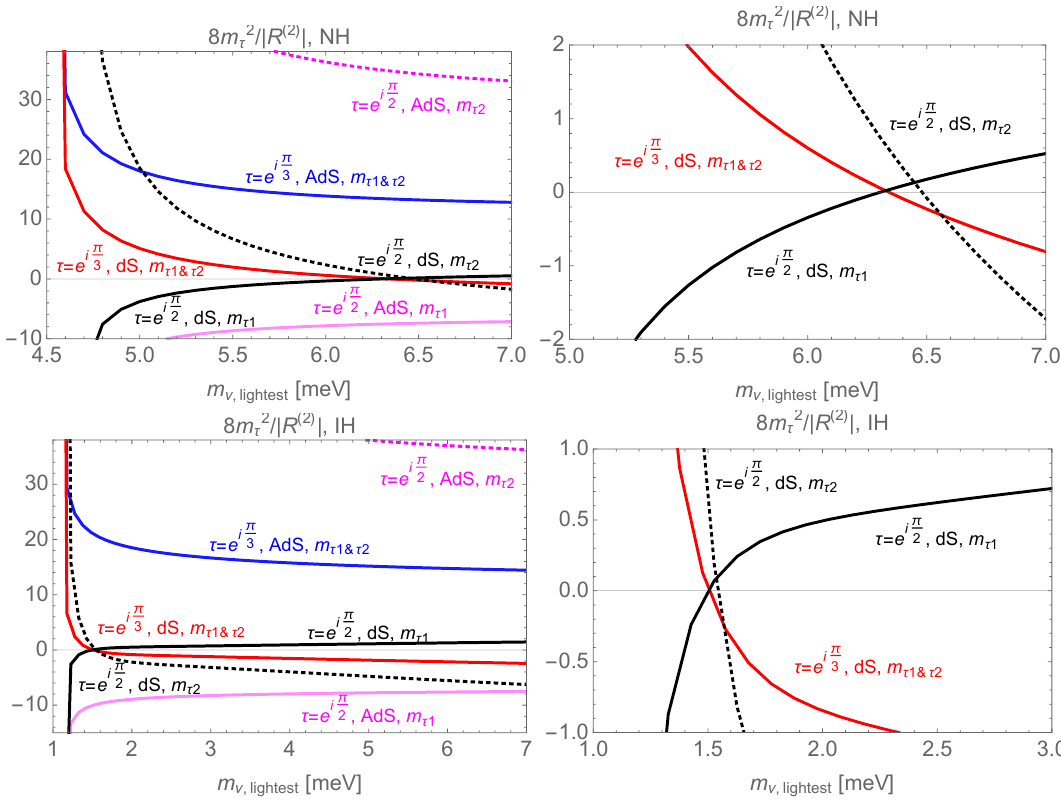
Figure 19 . Upper left: the mass and curvature ratio is plotted for the periodic Dirac neutrino with NH. The AdS 2 minimum corresponding to (cid:28) = e i(cid:25)= 3 is always stable. Upper right: the enlarged view of the upper left (cid:12)gure around 6 meV. One can see that the dS 2 minimum where (cid:28) = e i(cid:25)= 3 is stable for 4 : 5 meV . m (cid:23); lightest . 6 : 3 meV, while the dS 2 minimum where (cid:28) = e i(cid:25)= 2 is stable for 6 : 3 meV . m (cid:23); lightest . 6 : 5 meV. Lower left: same as upper left (cid:12)gure, but for IH.